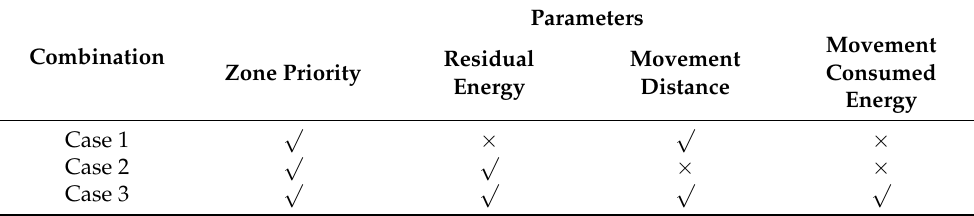
Table 4. Proposed parameter